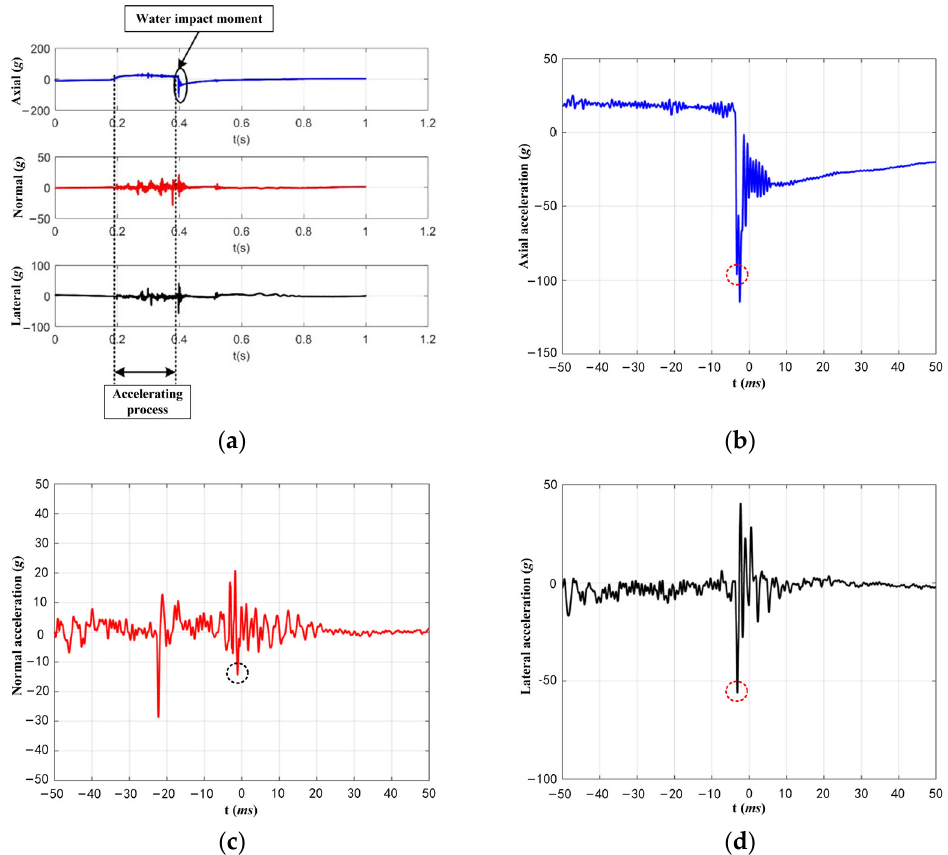
Figure 12. Three-axis acceleration of T01. ( a ) Original data recorded by sensor. ( b ) Axial acceleration. ( c ) Normal acceleration. ( d ) Radial acceleration.